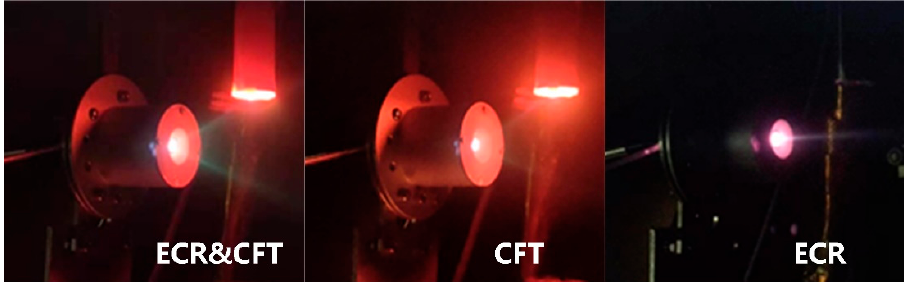
Figure 19. First-generation microwave discharge cusped field thruster, with several ECR surfaces marked out.